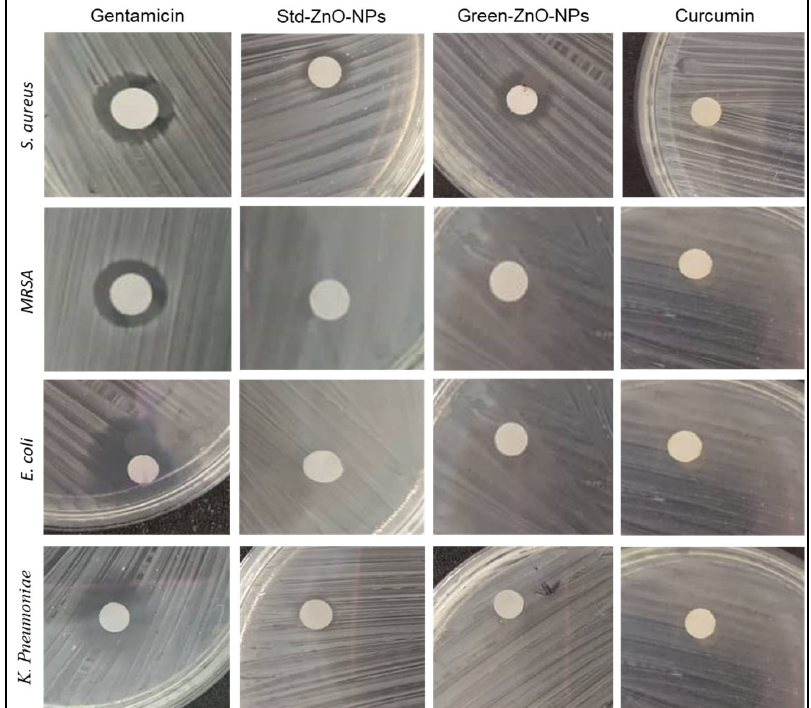
Figure 8. Zone of inhibitions of Gentamicin, Std ‐ ZnO ‐ NPs, Green ‐ ZnO ‐ NPs and curcumin against Gram ‐ positive and Gram ‐ negative bacteria.